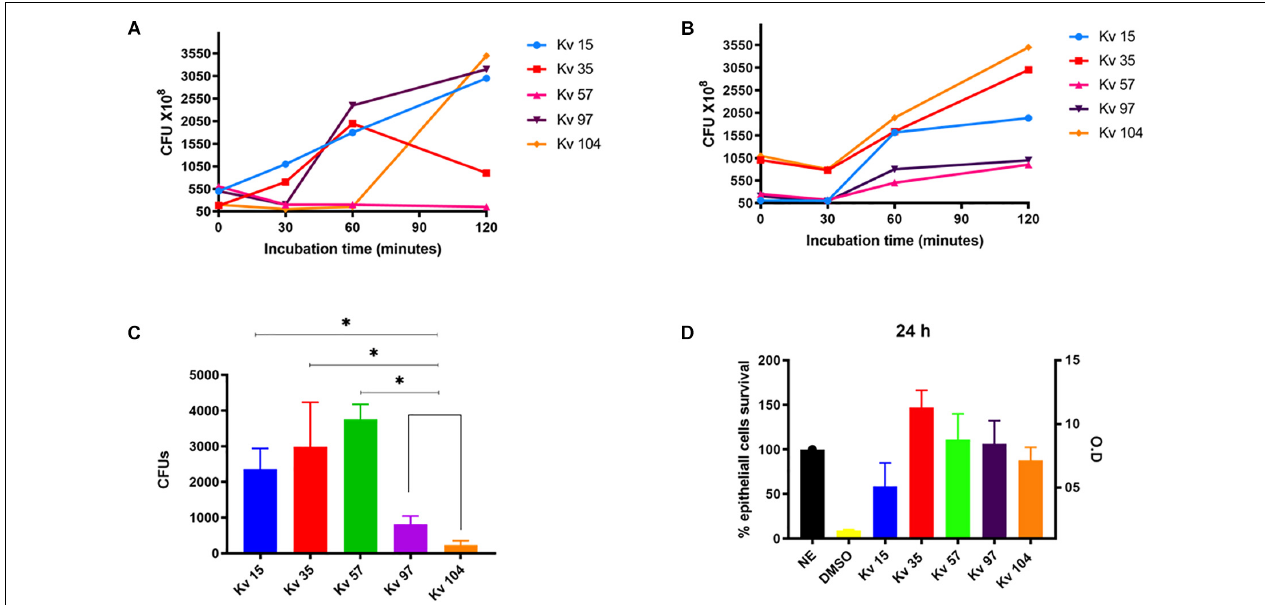
FIGURE 1 | Biological assays used to determine the pathogenic potential of Klebsiella variicola strains. (A) Bacterial survival after incubation in human blood for different times at 37 ◦ C. (B) Bacterial survival after incubation in human serum for different times at 37 ◦ C. (C) Bacterial invasion in HEp-2 cells. (D) Bacterial cytotoxicity to HEp-2 cells. The bacterial survival was determined by CFU counting of strains plated from the incubation in blood and serum. Bacterial invasion was determined by CFU counting of strains plated after HEp-2 lysis. Cytotoxicity to HEp-2 cells were determined by the Griss Method. All assays were performed in triplicate. ANOVA one-way were used for statical analysis, * p < 0.05 values were considered significant.